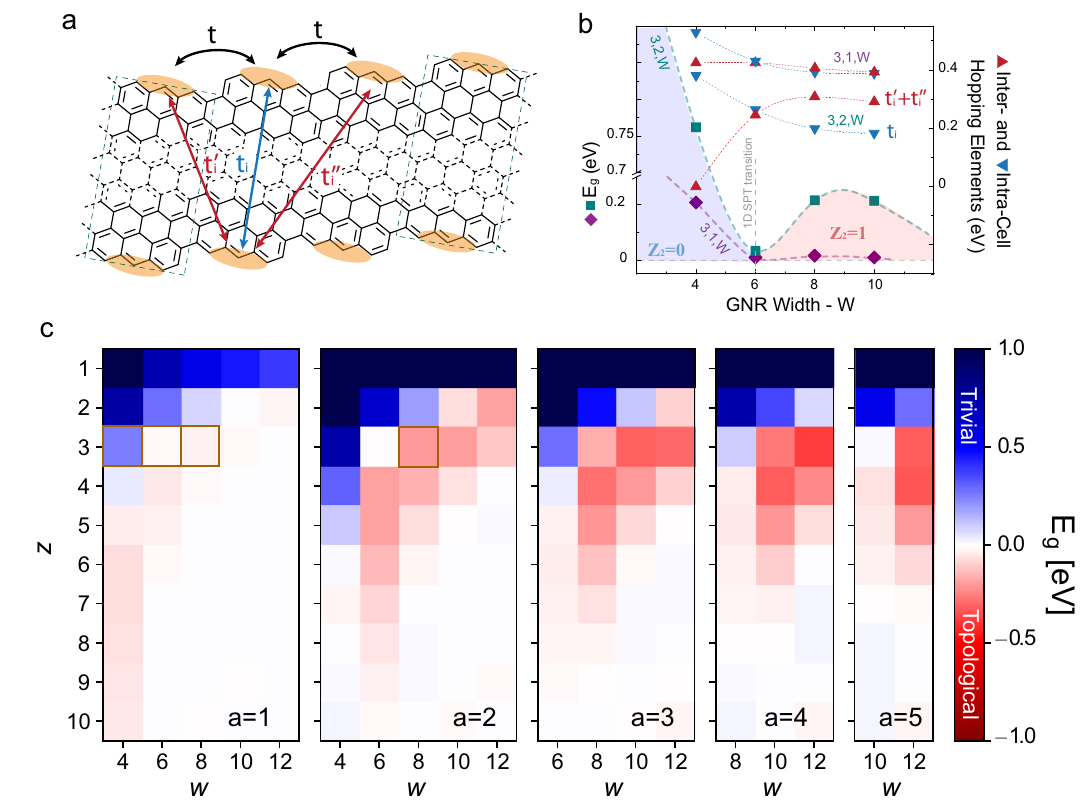
Fig. 4 SSH model and simulations of the band topology of chGNRs. a Modi fi ed Su-Shrieffer-Heeger model to explain the SPT phase transition of chGNRs with the width. b Evolution of the energy gap value and sign with the chGNR width, obtained by fi tting the mSSH model in a to frontier bands from 3NN TB þ t 00 simulations. (Right Ordinate) comparison of intra- ( t i ) and inter-edge (t 0 ) hopping elements obtained from the fi t, indicating that the topological i i transition occurs when both are balanced. c Color plots of the energy gap value and sign for the family of ( z , a , w ) chGNRs, showing that the topological transition is a global property of this family of chiral ribbons. Marked squares indicate the ribbons studied in this work. The red/blue color scale refers to the positive/negative sign of E g , de fi ned as ð(cid:2) 1 Þ Z 2 , where the Z 2 invariant is obtained from the Zak phase (Supplementary Note